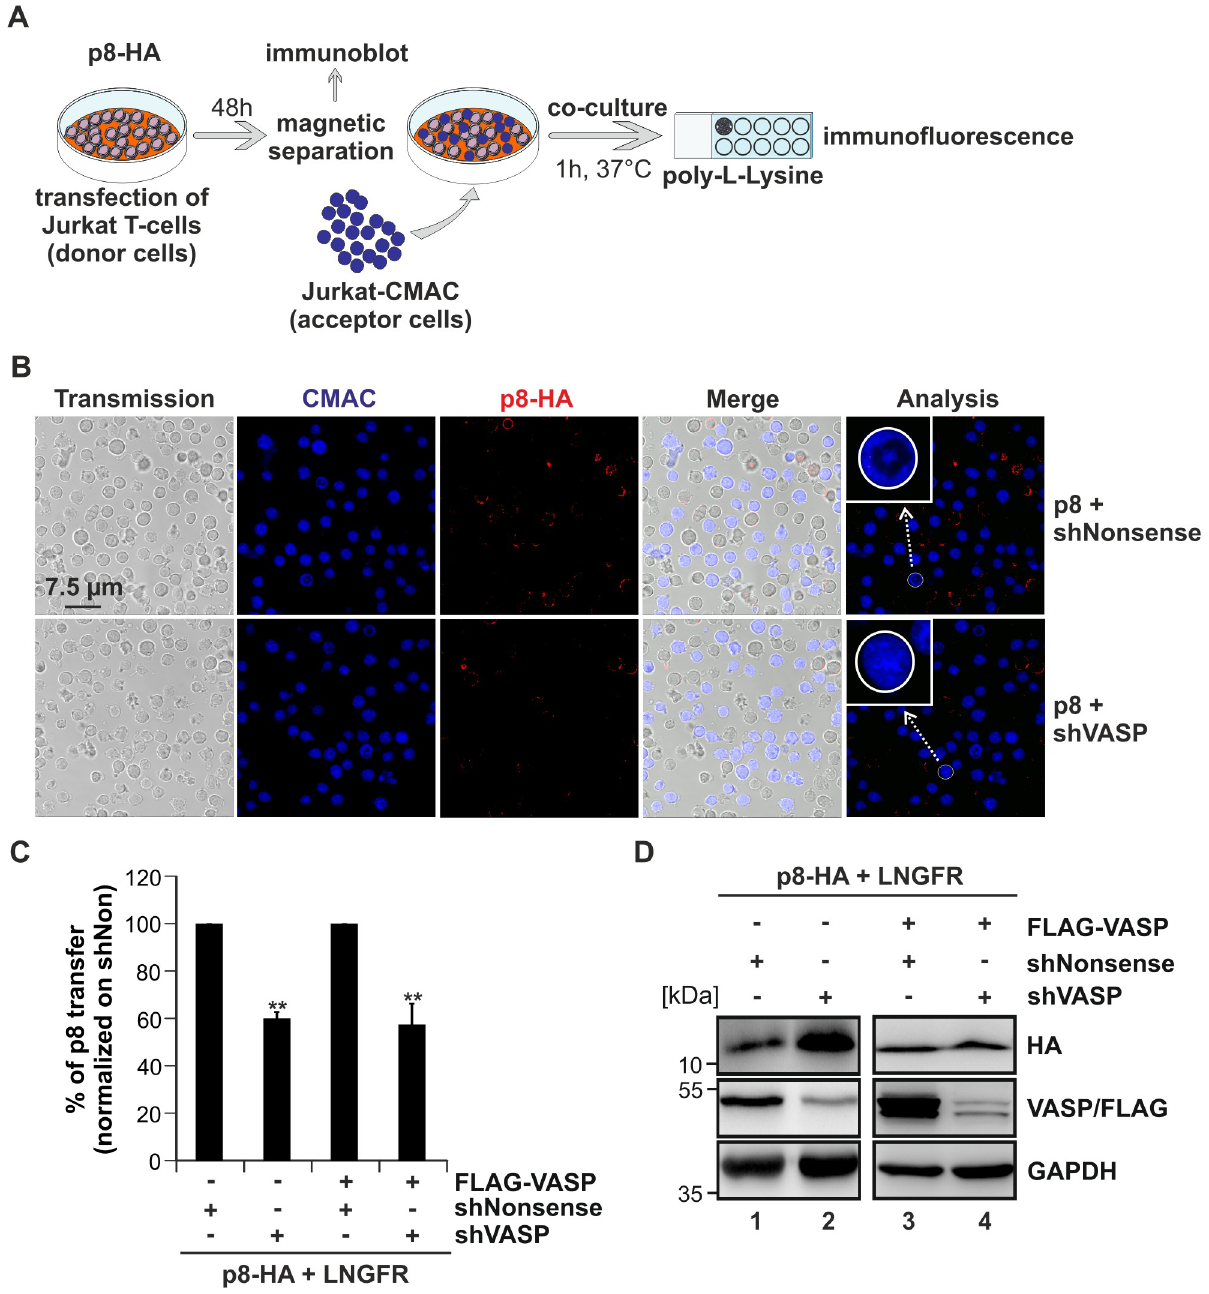
Fig 6. Repression of endogenous and overexpressed VASP reduces transfer of p8 to target T-cells. (A) Scheme of experimental setup. (B-C) Jurkat T-cells were transfected with expression plasmids p8-HA and pMACS-LNGFR. Additionally, FLAG-VASP or pEF (mock), shRNAs targeting VASP (shVASP1), or a control shRNA (shNonsense) were co-transfected. After 48 h, transfected cells were enriched by magnetic separation using anti- LNGFR-specific microbeads. Purified Jurkat T-cells were co-cultivated with acceptor Jurkat T-cells pre-stained with CellTracker Blue CMAC Dye (CMAC) on poly-L-lysine coated glass slides for 1 h at 37˚C. Thereafter, cells were stained with HA- and FLAG-specific antibodies and the respective secondary antibodies. Slides were covered with ProLong Gold antifade reagent and analyzed by confocal microscopy. The numbers of cells expressing p8 (red) within the acceptor Jurkat T-cells (blue) were counted (see white circle in blow up as example). (C) The mean of five independent experiments (15–20 optical fields each) normalized on the number of p8-donor cells, and on the respective shNonsense ± SE is shown and was compared using Student’s t-test ( �� , p < 0.01). (D) Repression of VASP was controlled by western blot analysis.